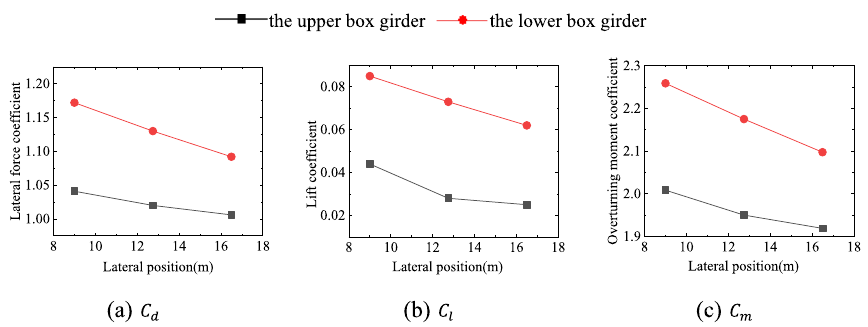
Fig. 16 Aerodynamic coefficients of the